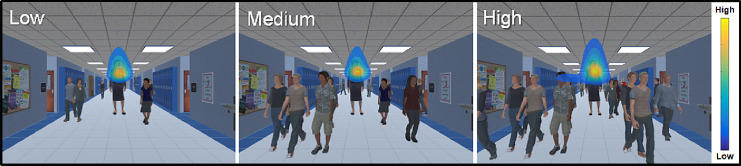
Heat maps illustrating the extent of eye movement search patterns overlaid on top of representative examples of low, medium, and high crowd density levels of visual distractors. The color scheme of the heat maps represents differing levels of gaze data density across spatial regions of the screen space (yellow indicates more time looking in an area, and blue indicates less time). There is consistent clustering of eye movements across the levels of distractor density, reflecting a tight flame shape around the target as they locate and pursue. Note further dispersion of gaze data from the target as crowd density increases.